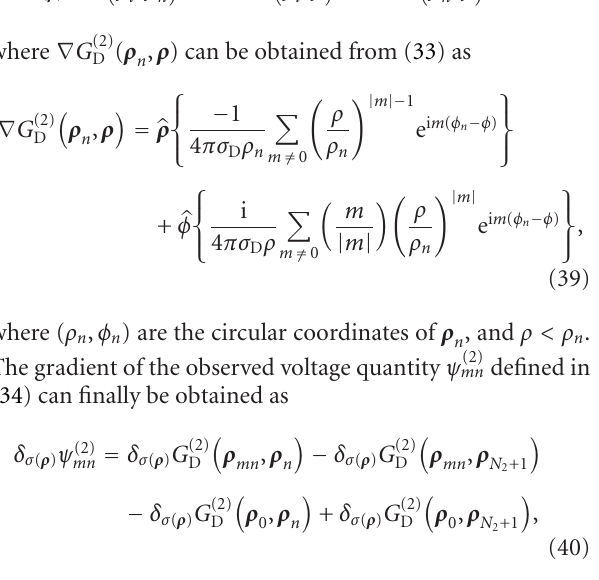
2 m long. The surrounding medium has relative permittivity (cid:2) = 5 and conductivity σ r D